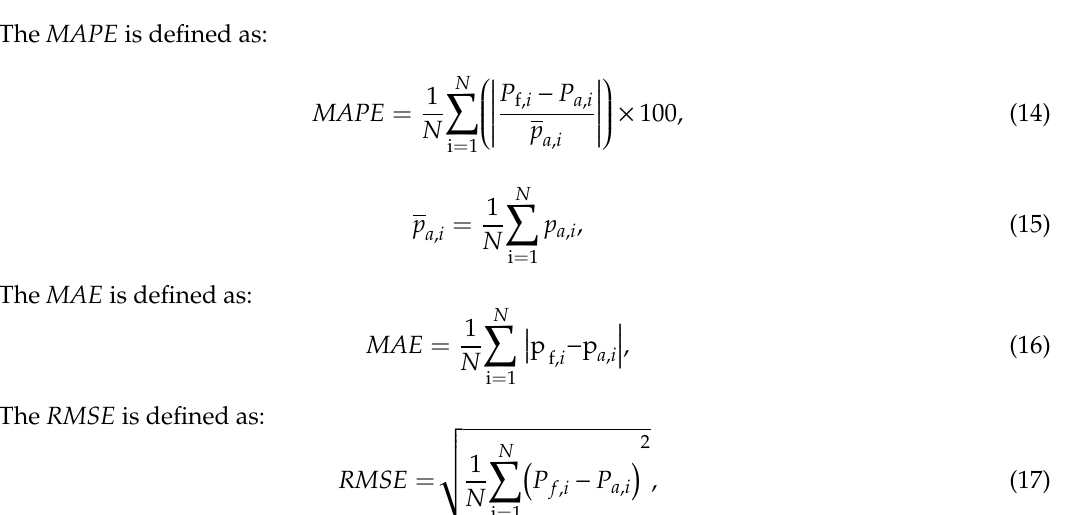
Figure 9. Forecasting result curve by different models for random days in SITE 4.